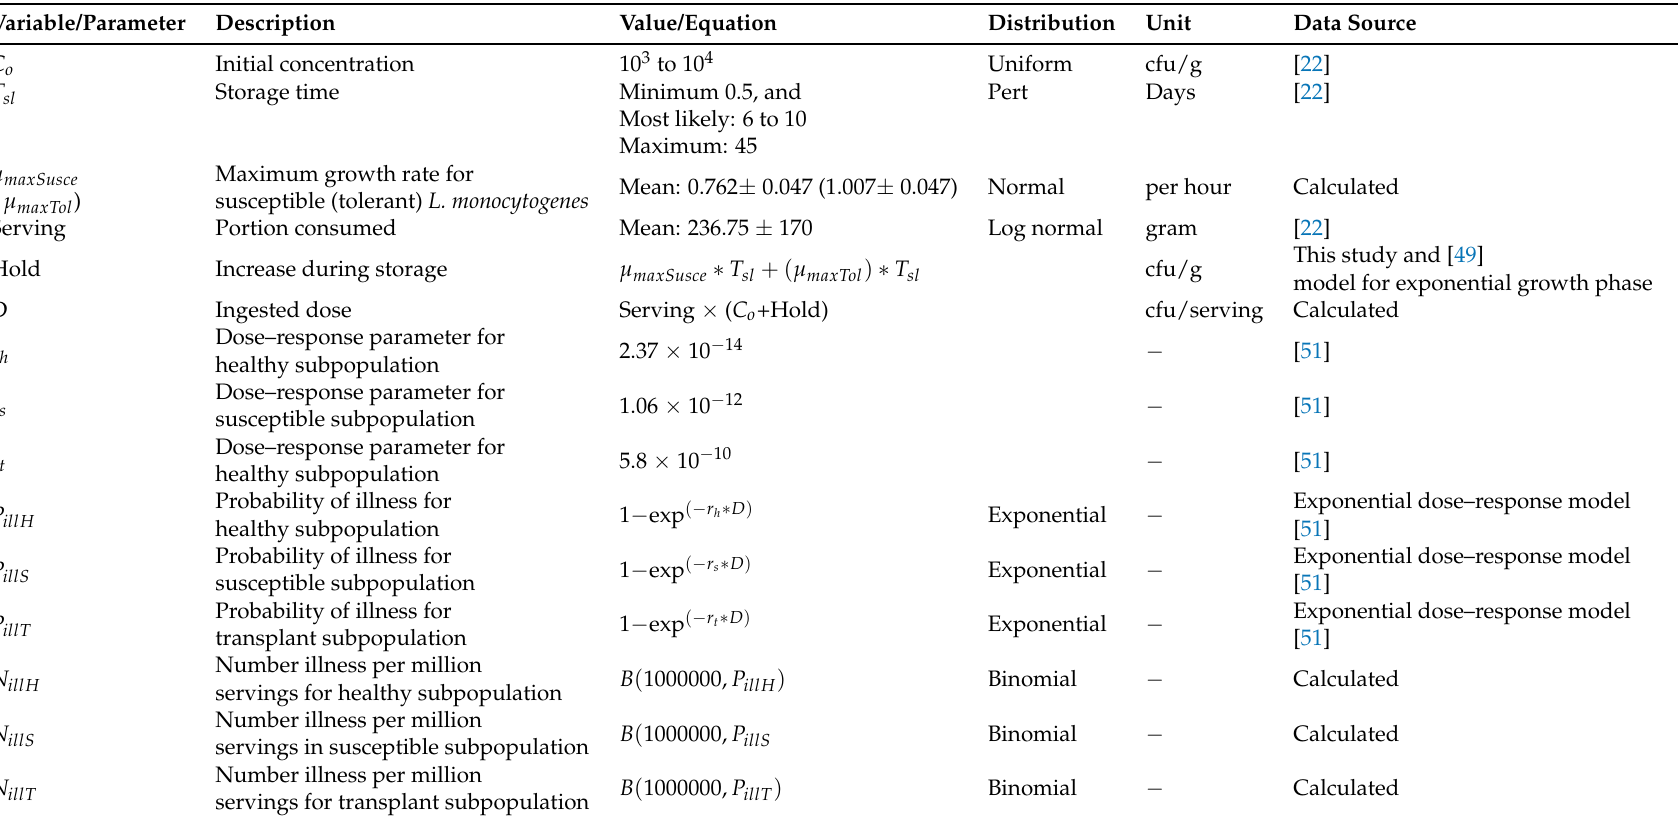
Table 1. Summary of the listeriosis quantitative risk assessment model for consumption of cultured milk at domestic level: variables, equations or distribution of the input parameters and data